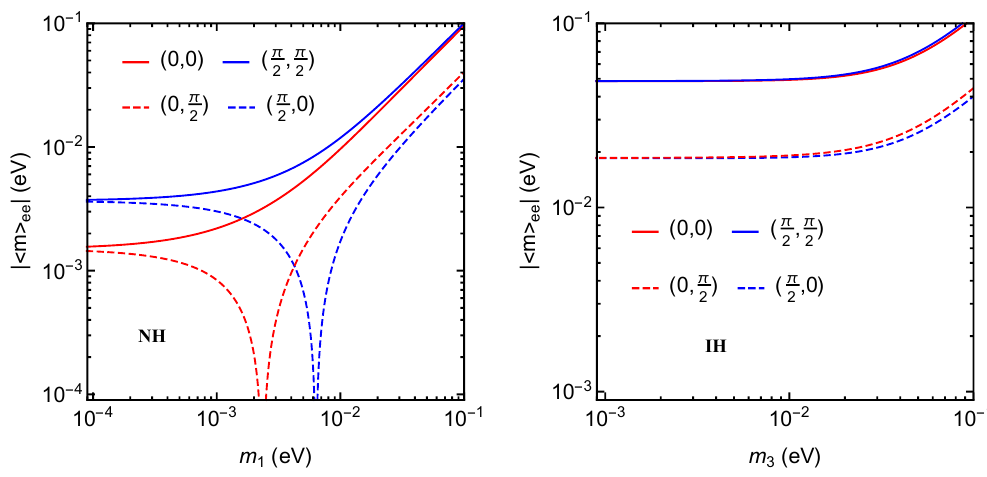
in the NH case or m in the IH 1 3